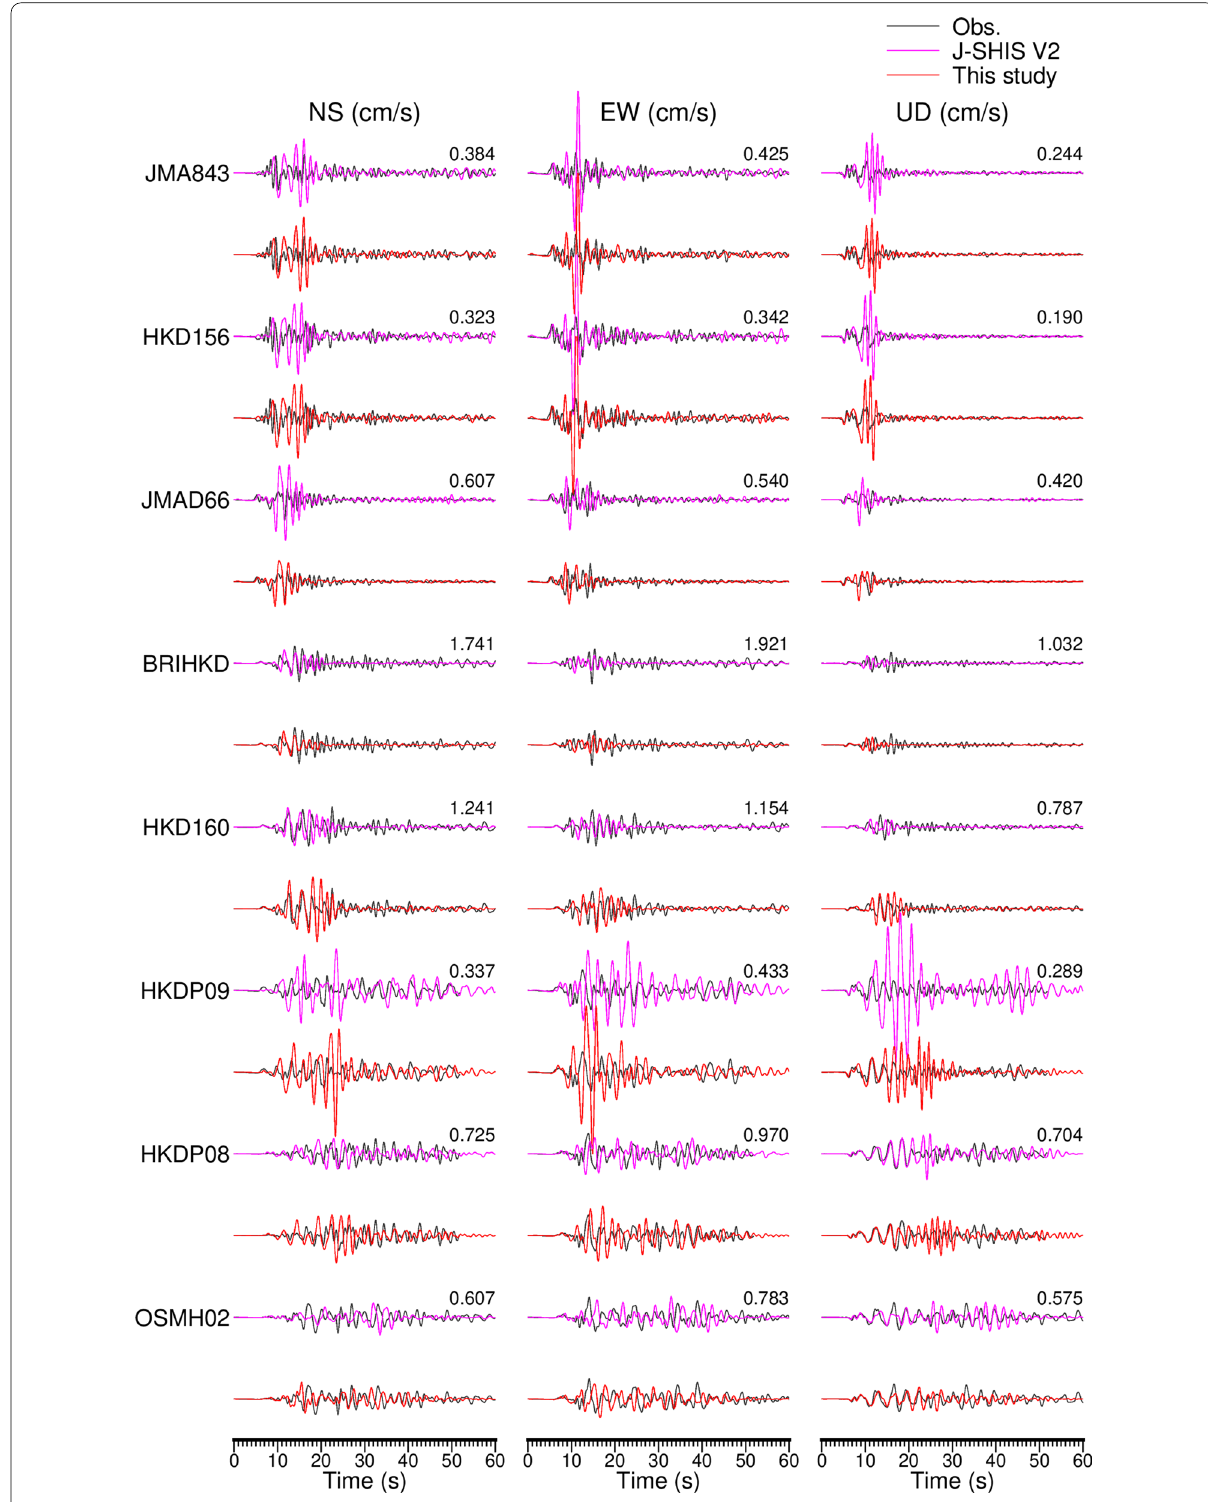
Fig. 11 Comparison of observed and simulated velocity waveforms. The observed velocity waveforms are plotted with gray lines. The simulated waveforms with J-SHIS V2 model and our new model are plotted with purple lines and red lines, respectively. The waveforms are bandpass filtered at 0.1–1 Hz. The number placed above each trace is the maximum amplitude of the observed waveform in cm/s. The origin of the horizontal axis corresponds to the origin time of the earthquake determined by